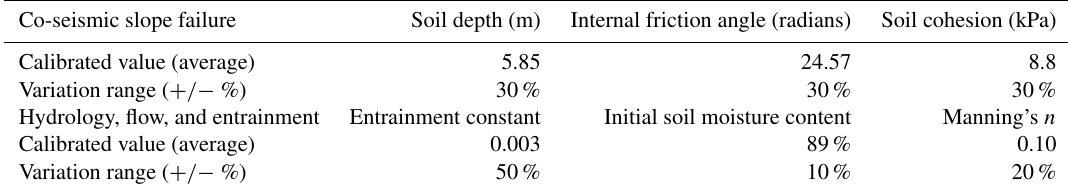
Table 7. Parameter settings for the ensemble